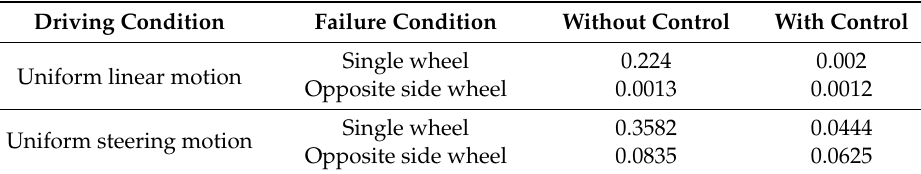
Table 3. Maximum yaw rate deviation with or without control (rad/s).